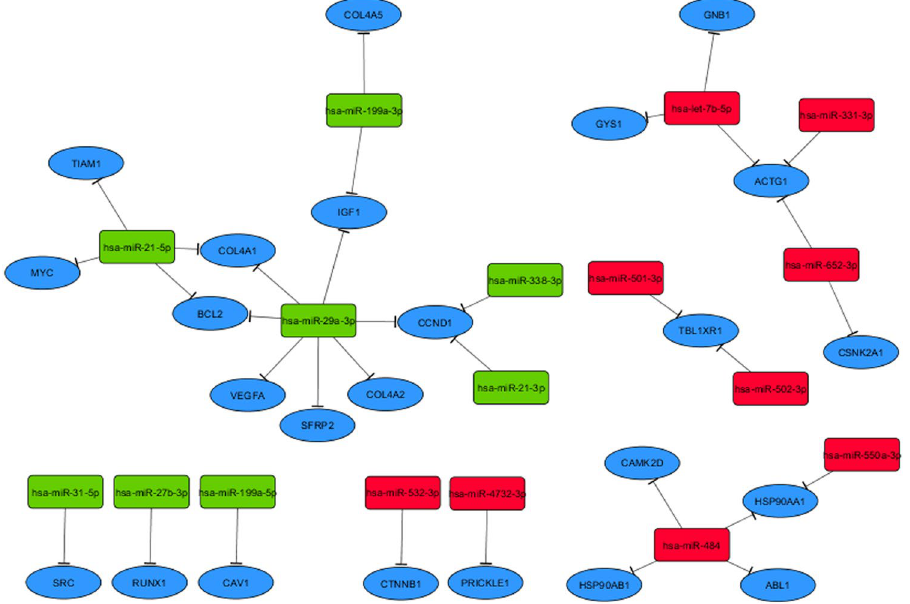
Figure 4. Potential interference of miRNAs with human cancer genes upon environmental exposure to PCBs, HCB and DDE. Red color indicates a downregulation and green color an upregulation of a miRNA with the exposure intensity. Blue color indicates cancer related genes derived from the KEGG pathways. All interactions are inverse correlations (r < − 0.4 and FDR <